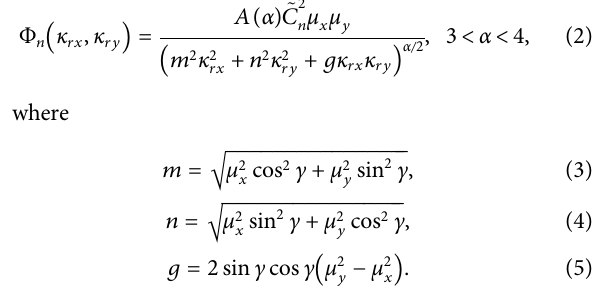
Figure 1 that for different values of power law α , anisotropic factors μ x and μ y and the variation of the anisotropic tilt angle γ has no effect on the